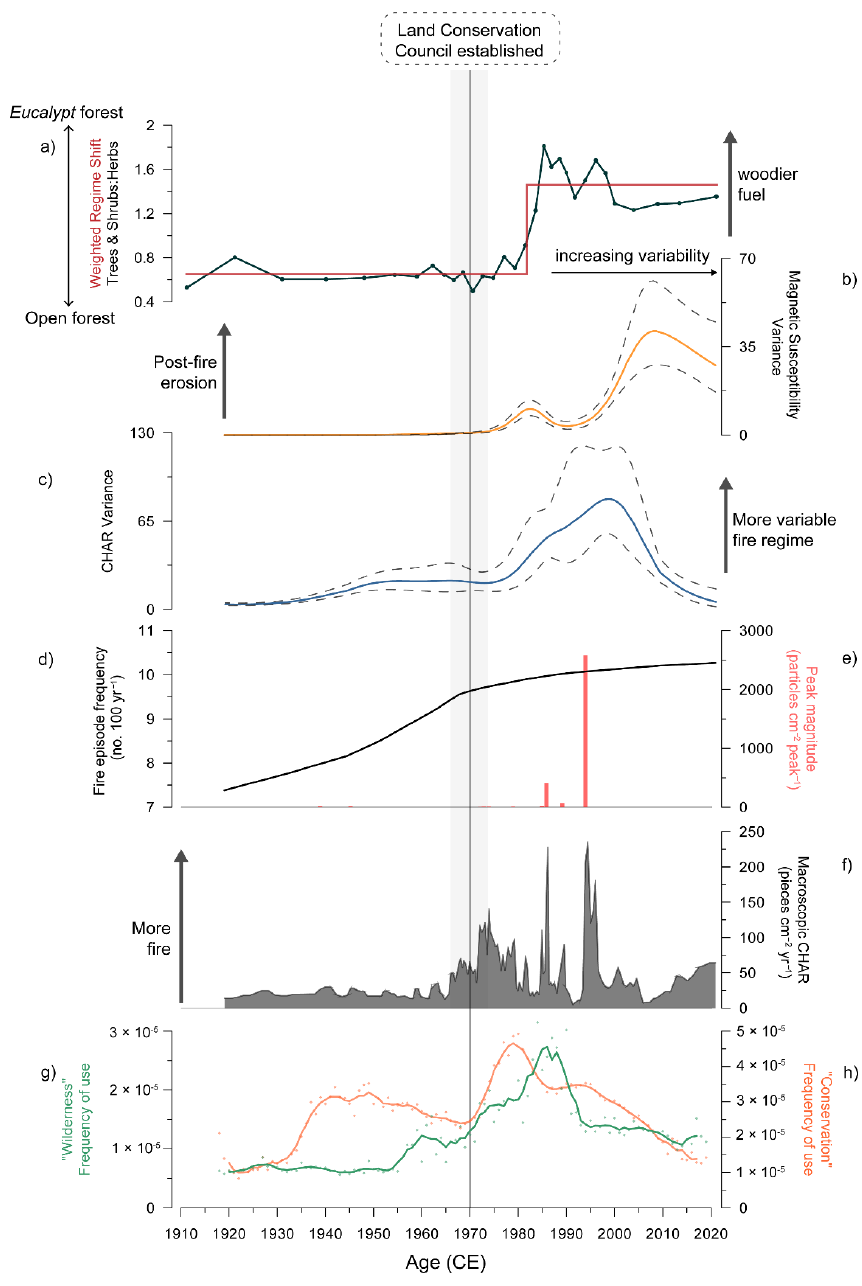
Figure 6. A summary plot of Tooculerdoyung Lagoon data ( a ) Percent ratio between Tree & Shrub taxa and Herb taxa (green line) with weighted regime shift (red line). The Rodionov sequential re- gime shift detection method [136] represents successive applications of student’s t -test to determine if the addition of a new observation to a set of L observations significantly ( p = 0.05) changes the mean value of the time series, i.e., regime shifts; ( b ) Magnetic susceptibility generalized additive model (GAM) fitted variance (orange line) and confidence intervals (grey dashed lines); ( c ) CHAR GAM fitted variance (blue line) and confidence intervals (grey dashed lines); ( d ) Fire episode fre- quency (black line) (window-width = 100 years); ( e ) Peak magnitude (particles cm −2 peak −1 ) (red bars); ( f ) Macroscopic charcoal accumulation rate (Macroscopic CHAR, pieces cm −2 yr −1 ); ( g ) ‘Wil- derness’ frequency of use Google ngram data (green) from 1918; ( h ) ‘Conservation’ frequency of use Google ngram data (orange) from 1918. The vertical grey line represents the establishment of the